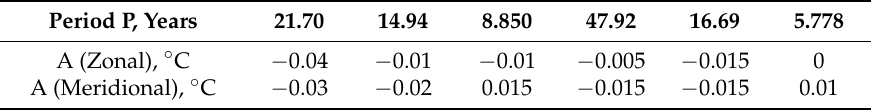
Figure 6. The result of adding four regime-dependent components to the previous analysis, compared with residual HadCRUT4 decadally smoothed GMST anomaly residuals, and with anomalies lagging the tidal combination by 0.40 years. Residuals calculated from anomalies prone to “end effects” in the smoothing process are labeled “less accurate”. Table 4. Regime-dependent amplitudes for cosine functions for tidal components with a 0.40-year lead time in relation to the decadally smoothed GMST anomaly residuals, in the Figure 6 simulation. The amplitude A entries are in °C for each component, and are given for each period P by Acos(2π[t + 0.4 − 2039.96]/P) with t in decimal years.